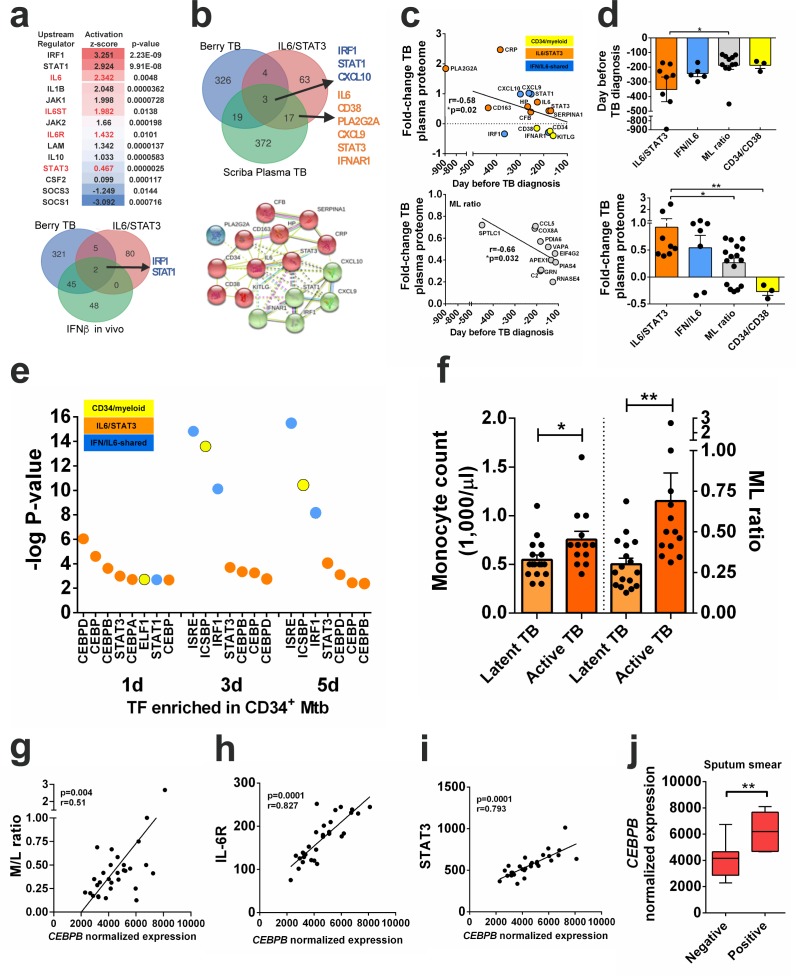
IL6/IL6R/CEBPB gene module is enriched in active TB transcriptome and proteome and correlates with monocyte expansion.(a) Top panel: upstream regulators significantly enriched by causal Ingenuity Pathway Analysis (IPA) in monocyte transcriptomes from patients with active TB (GSE19443), ranked by activation z-score, p-values are corrected for genome-wide testing (FDR). Bottom panel: IRF1 and STAT1 are the top upstream regulators shared between the ‘Berry TB’ disease signature (Berry et al., 2010) (GSE19435, GSE19439, GSE19444), the ‘IL6/STAT3’ pathway (Hallmark GSEA) and the human ‘in vivo IFN-β” signature (GSEA HECKER_IFNB1_TARGETS). (b) Top panel: overlap between the ‘Berry TB’ disease signature, the ‘IL6/STAT3’ pathway and the ‘Scriba plasma TB’ proteomic signature (Scriba et al., 2017) identified ‘IFN/IL6-shared’ and ‘IL6/STAT3-specific’ signatures. Bottom panel: significant STRING protein-protein interaction network (p<10−16) for ‘IFN/IL6-shared’ genes (green marbles) and ‘IL6/STAT3’ genes (red marbles), clustering separately by k-means. (c) Top panel: significant linear increase over time before active TB diagnosis in plasma proteome (Scriba et al., 2017) for ‘CD34/myeloid’ (yellow), ‘IL6/STAT3’ (orange) and ‘IFN/IL6-shared’ (blue) clusters found in (b). Bottom panel: monocyte/lymphocyte (ML) ratio gene set members defined by Naranbhai et al. (2015) over time before active TB diagnosis in plasma proteome (Scriba et al., 2017).(d) Top panel: increased ‘IL6/STAT3’ cluster protein expression precedes monocyte expansion markers (ML ratio gene set) in the TB plasma proteome. Bottom panel: data as in d) shows significant higher fold-changes for ‘IL6/STAT3’ vs. ‘ML ratio’ or ‘CD34/myeloid’ cluster members. *p-value<0.05, ** p-value<0.01. (e) Transcription factor enrichment analysis (GSEA) of differentially expressed genes determined by RNA-seq in Mtb-exposed CD34+ cells in vitro (n = 3 donors). (f), monocyte count and ML ratio in samples from latent vs active TB patients from Berry et al. (2010) reanalysis. *p-value<0.05, ** p-value<0.01 between active TB vs latent TB groups. Transcriptional data of whole blood reanalysis from Berry et al. (2010) shows a significant correlation of CEBPB transcripts with g) M/L ratio; h) IL6R; i) STAT3 transcript levels, and j) mycobacterial positivity in sputum smears in patients with active TB. ** p-value<0.01 between positive vs negative groups.10.7554/eLife.47013.021Figure 5—source data 1.Raw data from Figure 5.